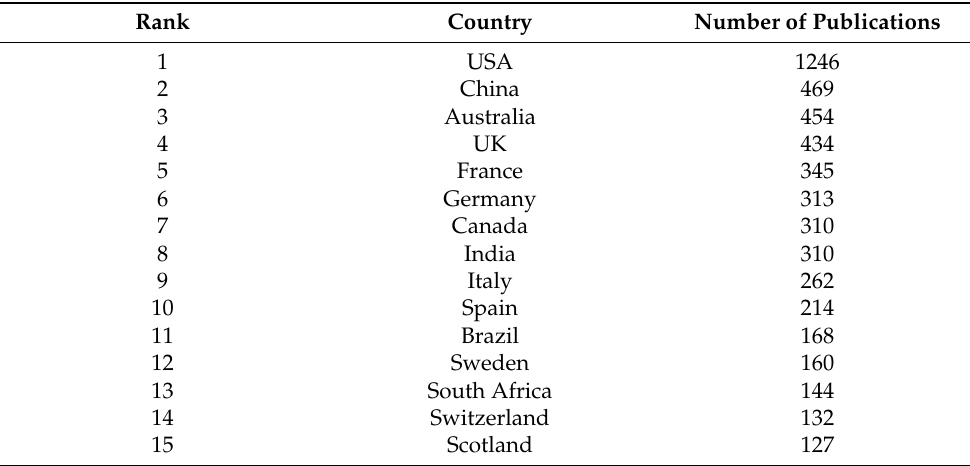
Table 2. Top 15 countries in terms of number of articles published. Rank